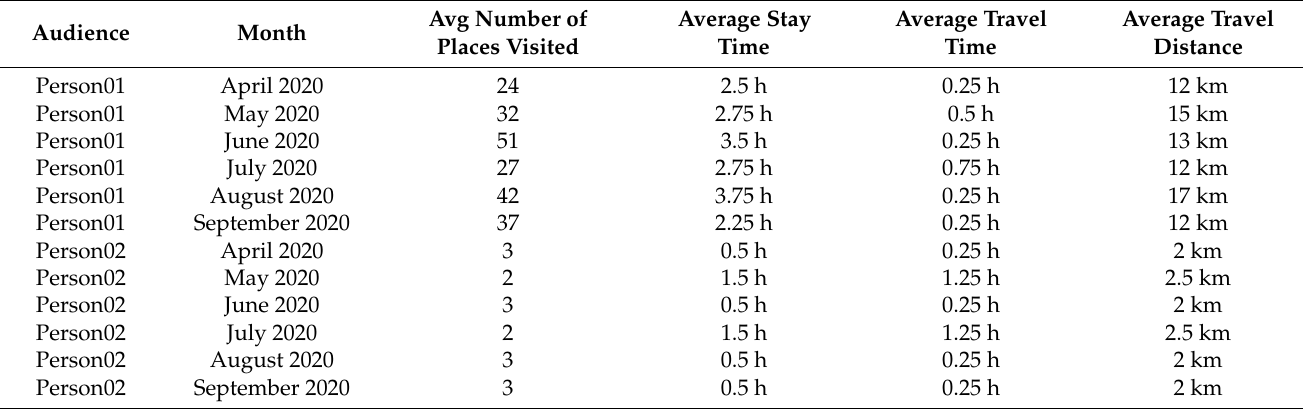
Table 10. Audiences’ monthly mobile-related data.